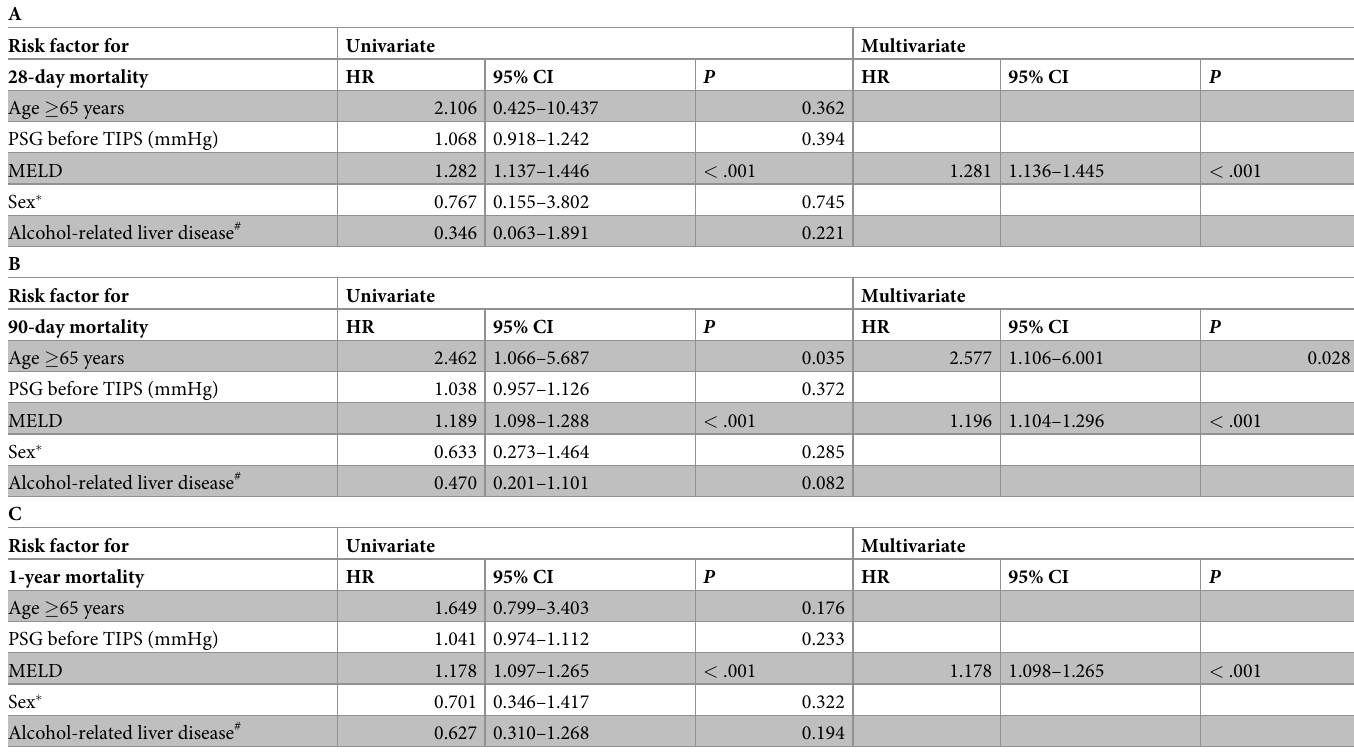
Jitter and line plots (S1 Fig). Besides, the matching yielded absolute SMDs for the matching covariates, which were < 0.25 representing no large imbalance (S1 Table). No significant dif- ferences were observed in any of the matching covariates after the matching procedure (Table 4). Of note, the MELD scores, supposed to represent the most important confounder, were notably balanced between the groups (12.6 vs. 13.0; p = 0.815). Subsequent comparison of survival between the matched elderly TIPS and paracentesis cohort revealed no significant difference in 1-year survival between patients treated with either TIPS or paracentesis (p = 0.419; Fig 3). Furthermore, mortality after 28 and 90 days after TIPS placement or first paracentesis was also similar (p = 0.196 and p = 0.808; S3 Fig). Discussion When ascites becomes refractory the patients’ prognosis is dramatically aggravated [29]. By direct reduction of the portal venous pressure gradient TIPS represents a powerful tool for Table 3. A. Uni- and multivariate Cox regression analyzing risk factors for 28-day survival. B. Uni- and multivariate Cox regression analyzing risk factors for 90-day survival. C. Uni- and multivariate Cox regression analyzing risk factors for 1-year survival.